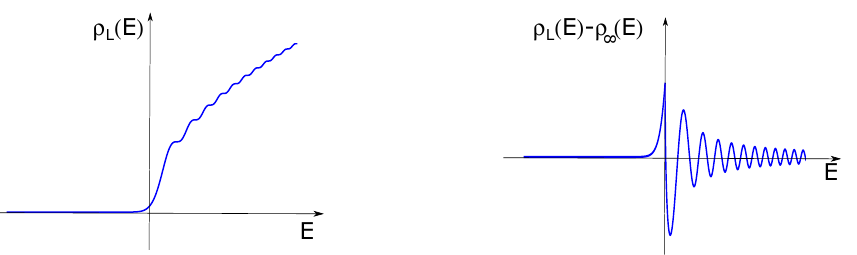
Figure 23 . Left: spectral density (E.9) for L = 50. Right: (cid:12)nite L correction on (cid:26) 1 ( E ). The high-frequency wiggles (E.12) and the exponential tail (E.13) at negative energies